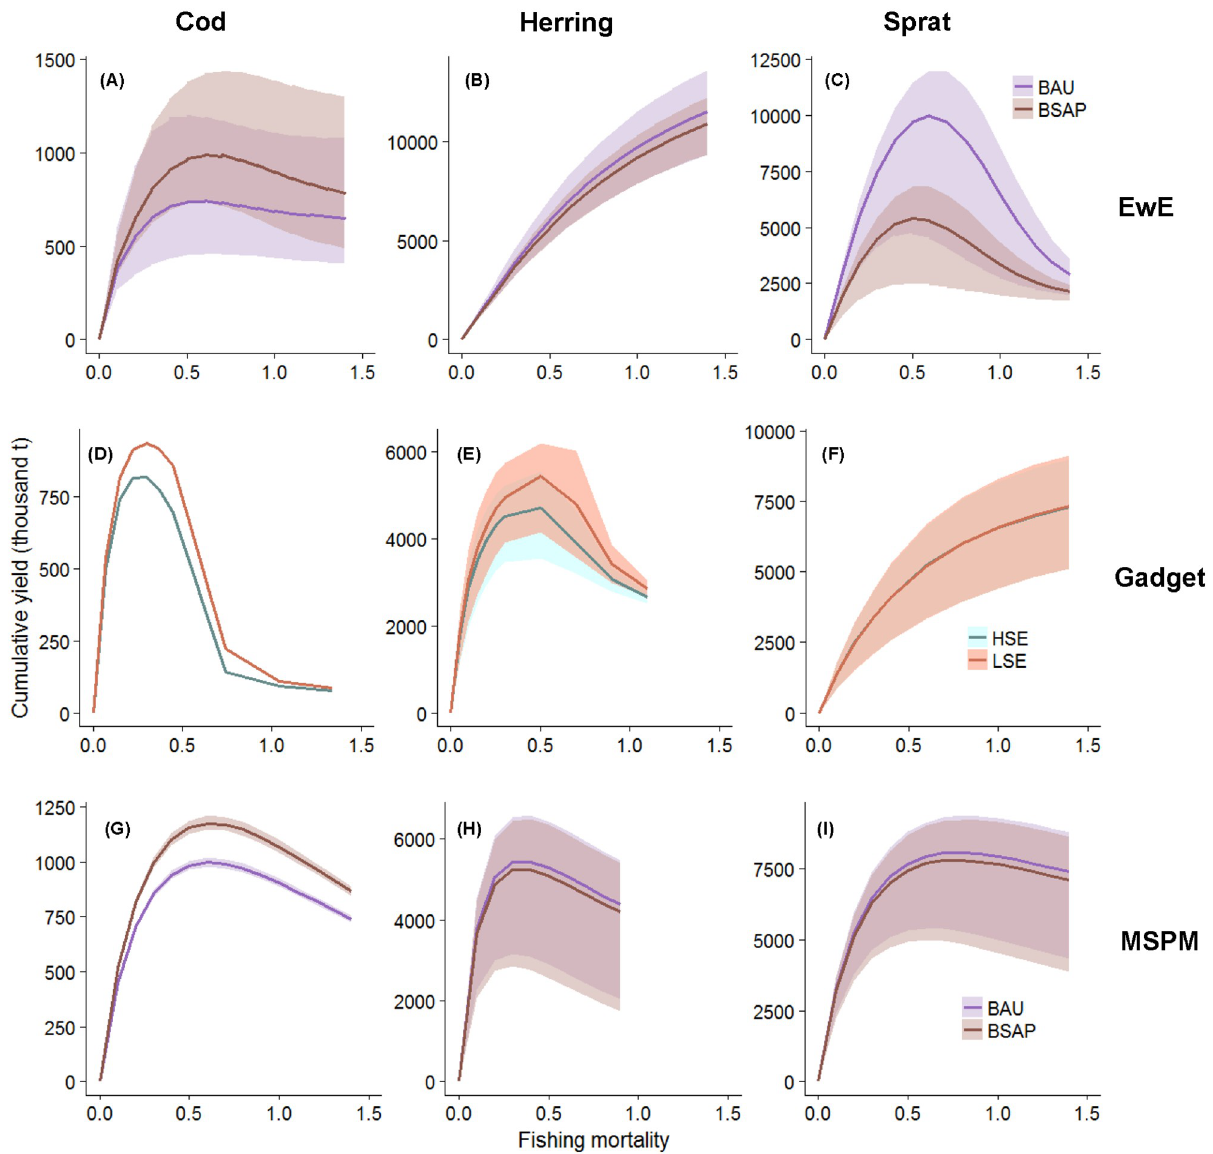
Fig 4. Relationship between fishing mortality rate (F, Table 2) and cumulative (2014–2032) yield for cod (left), herring (middle) and sprat (right column) projected by EwE (A-C), Gadget (D-F) and MSPM (G-I), under all cross-combinations of Fs for other stocks across all environmental scenarios. Shaded areas indicate the effect of varying the Fs of other stocks on the yield of the focal stock. Purple areas indicate the range of cumulative yields under the Business-As-Usual (BAU) and brown ones those under Baltic Sea Action Plan (BSAP) scenario (EwE, MSPM). Light blue areas indicate the range of cumulative yields under the high seal growth rate (HSE) scenario, and orange ones those under the low seal growth (LSE) scenario (seal effect visible in Gadget but not in EwE).